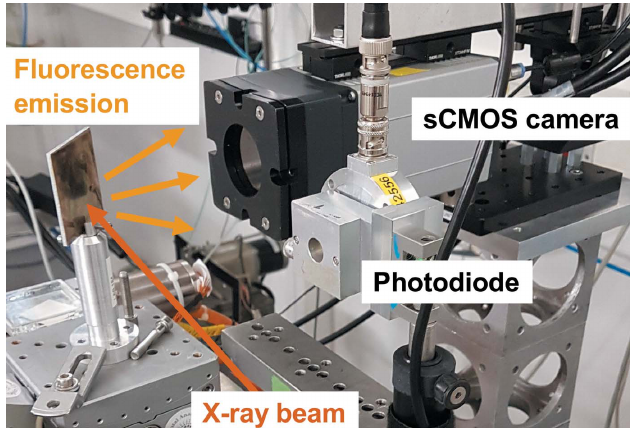
Figure 4 The experimental setup for measurement of single X-ray photons. The fluorescent target is oriented at 45 (cid:6) and the camera at 90 (cid:6) , with respect to the beam path.